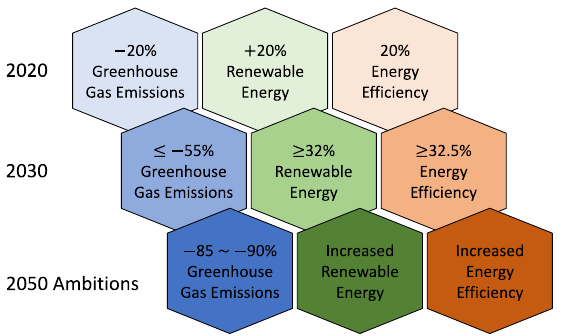
Figure 3. EU targets for renewable energy technologies penetration with GHG reduction [14] modified with new proposed targets [15].